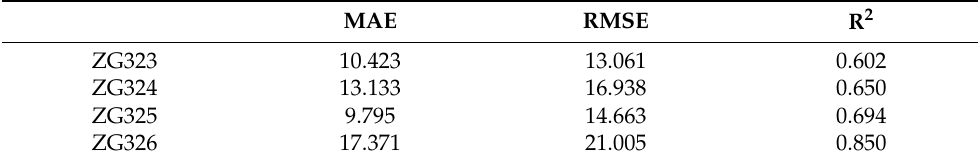
Table 5. Prediction accuracy of periodic displacement in ZG323 to ZG326.